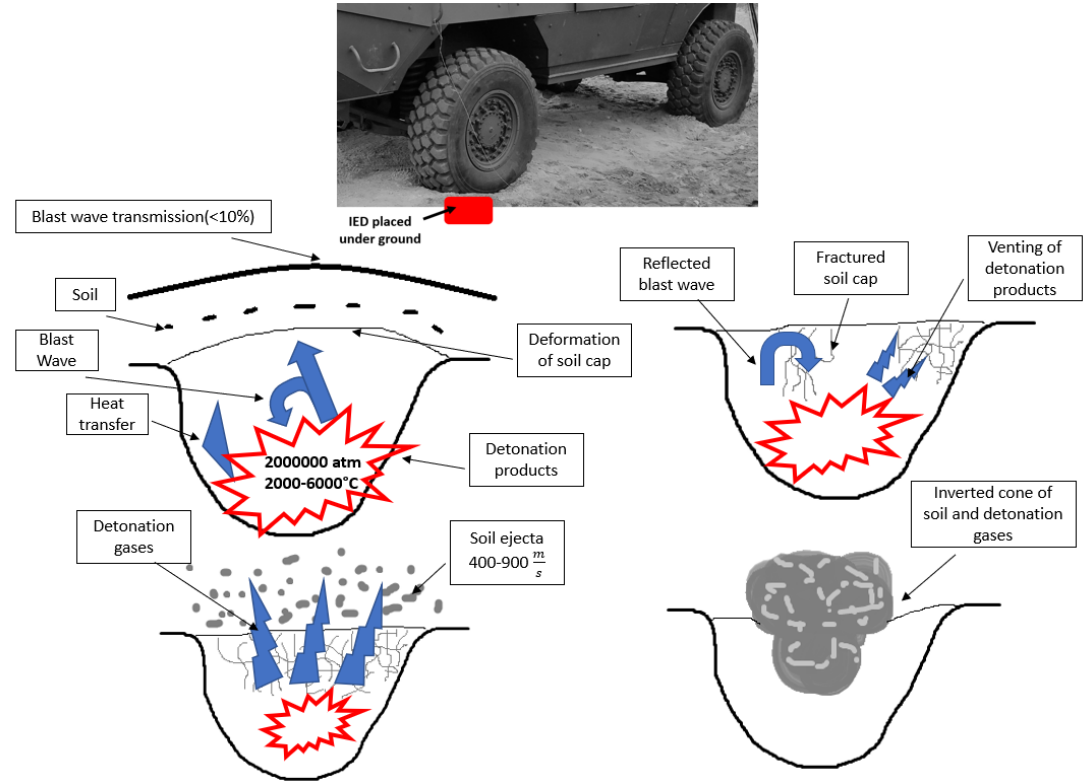
Figure 4. Physics of a mine explosion under a vehicle. Own study based on [25].